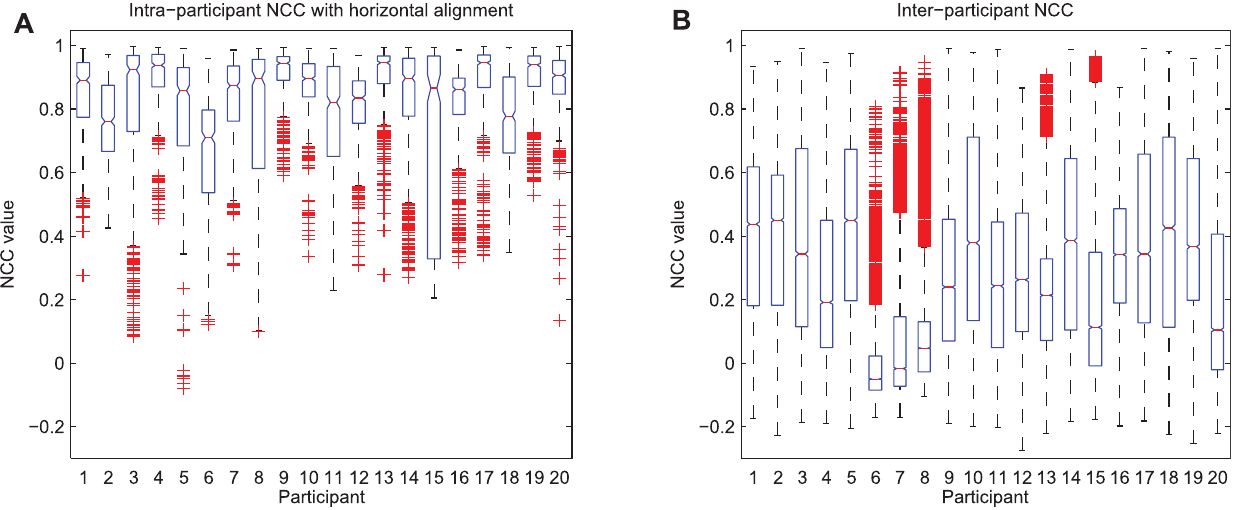
Figure 5. Box plots of the intra- (left panel A) and inter-participant (right panel B) NCC values for all 20 participants. Each box represents the distribution of NCC values for one participant, while ‘ + ’ symbols denote outliers (values beyond 1.5 interquartile ranges from the median).